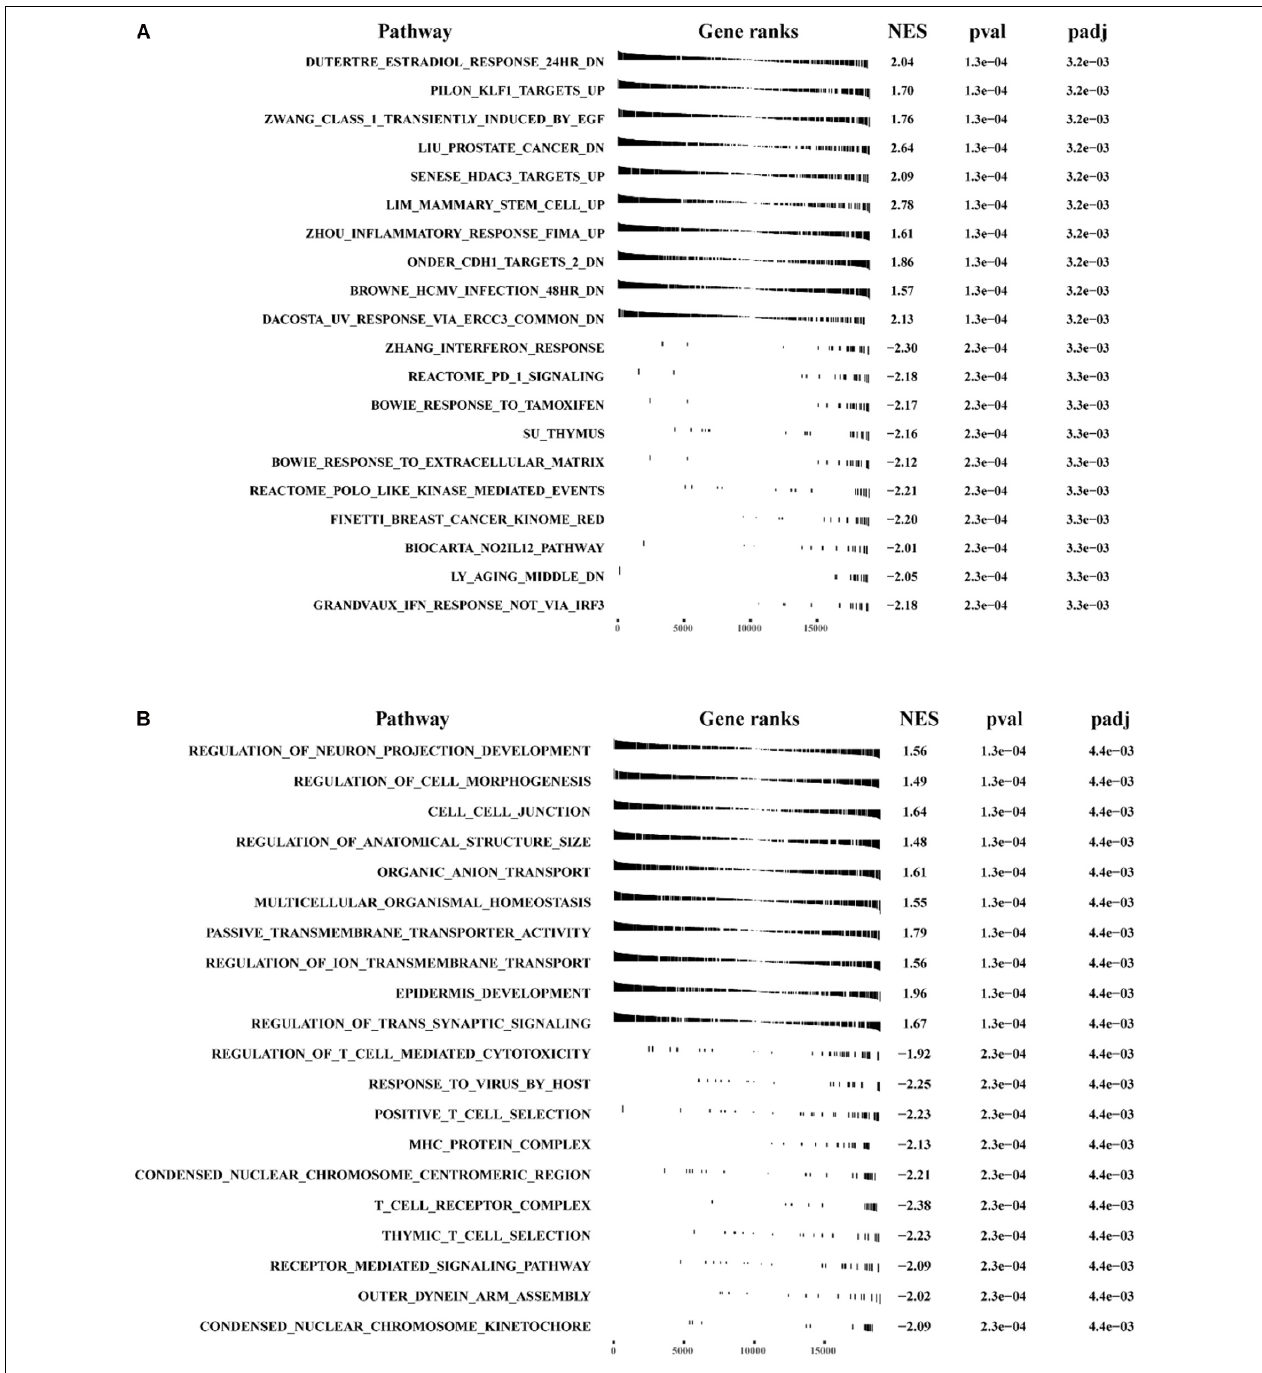
FIGURE 10 | The GSEA analysis for pathway enrichment between the high-risk group and the low-risk group. GSEA enrichment analysis was performed using (A) “c2.all.v7.0 symbols.gmt” and (B) “c5.all.v7.0 symbols.gmt” as the reference gene sets.